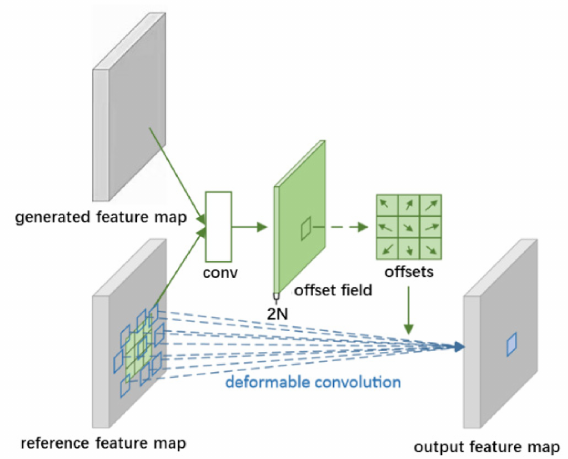
Figure 6. Architecture of modified deformable convolution based on reference feature